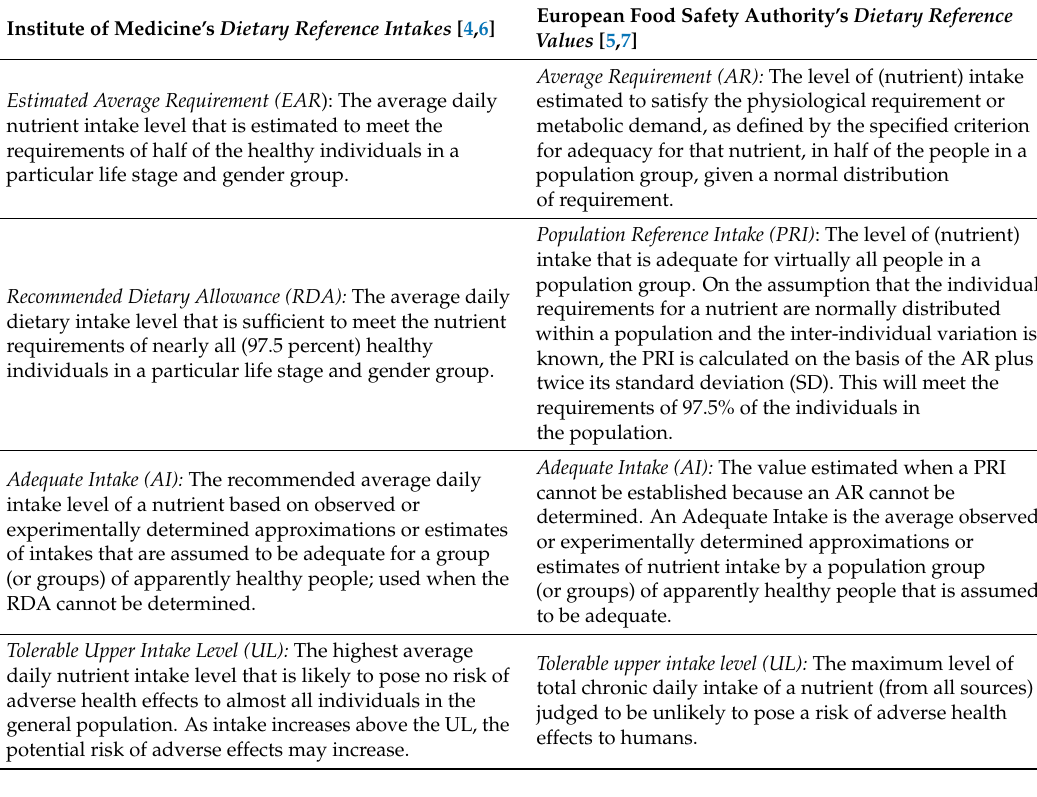
Table 1. Definitions for the constituent Dietary Reference Intakes and Dietary Reference Values.